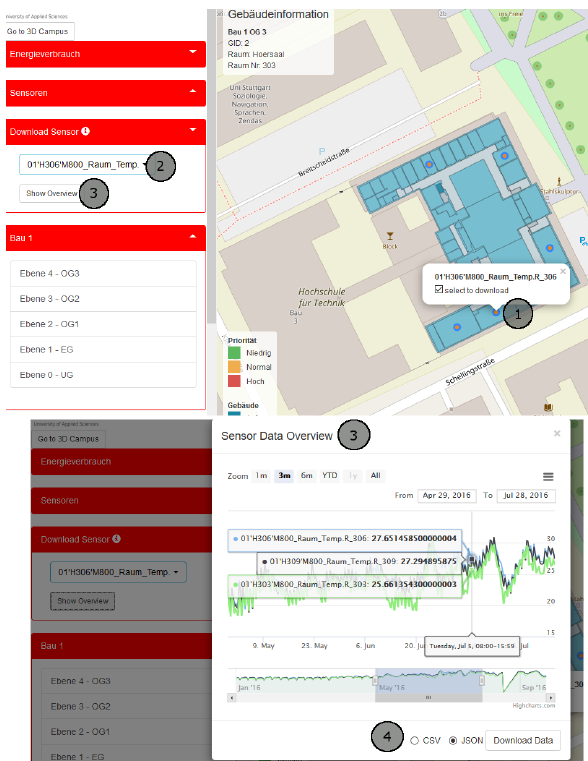
Figure 6. 2D visualization web interface. (Top) Data download procedure. 1) Users can select sensors to download by ticking a popup checkbox. 2) A list of selected sensors. 3) A button to show an overview of selected sensors data. (Bottom) Sensor data overview of selected sensors in a graph. 3) Room temperature measurements of three different rooms from 29 April 2016 until 28 July 2016. Users can see the measurement from a specific time interval by hovering the cursor on the graph. 4) Data format selection and a download button. Base Map c (cid:13) OpenStreetMap contributors.